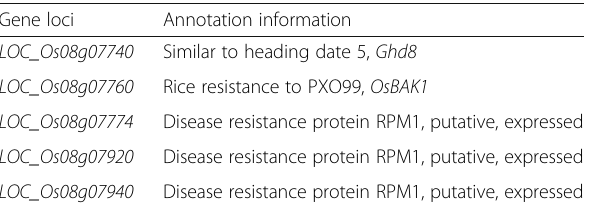
Table 4 The candidate genes that might be involved in disease resistance at the major QTL region of qFsr8 –